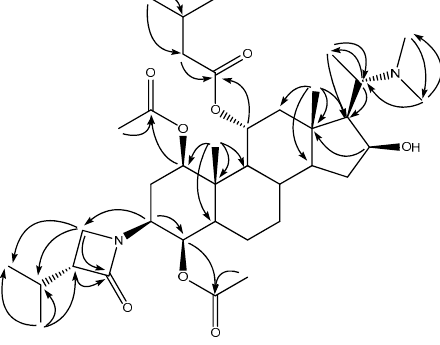
Figure 2. Key HMBC (H → C) correlations for 1 .